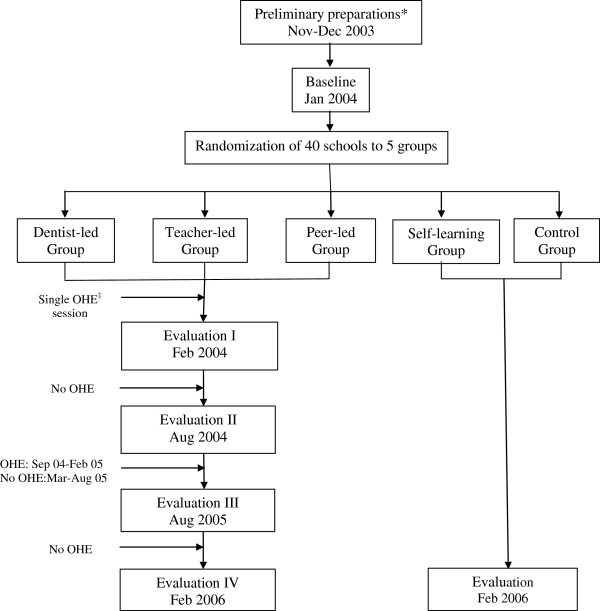
Schematic diagram of OHE component of the Preventive Oral Health Care Project.*Permissions; and designing and testing of OHE material, questionnaire, clinical forms; training of educators. ‡Oral Health Education.